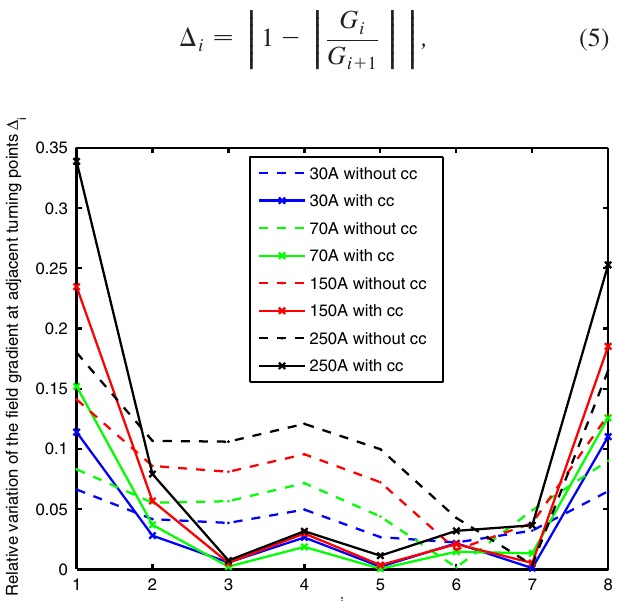
FIG. 11. (Color) Ratio of the absolute field gradients at adjacent turning points with and without the YBCO loop system for the different currents I main of Table I. (cid:1) i ¼ j 1 (cid:3) j G i turning point pair i . The significant increase at the beginning and end is due to the finite length of the induction-shimming system. The first (last) turning point is at the beginning (end) of the first (last) loop of the induction-shimming system.